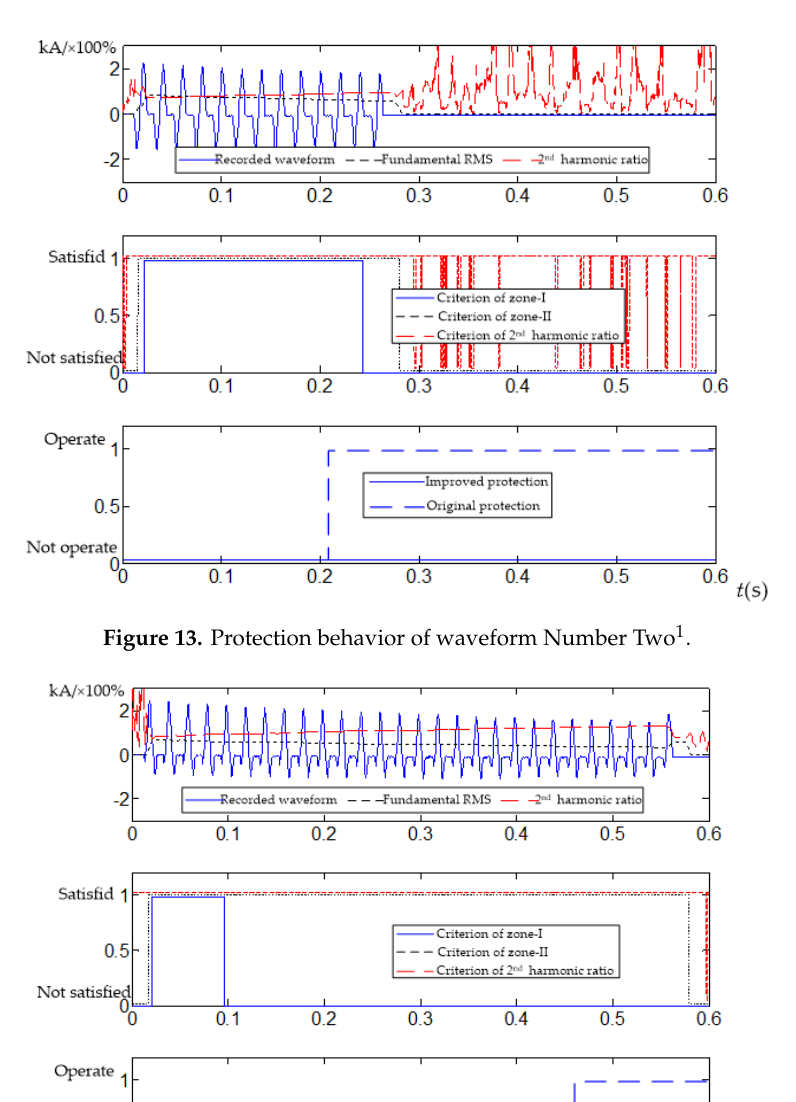
Figure 14. Protection behavior of waveform Number Three.